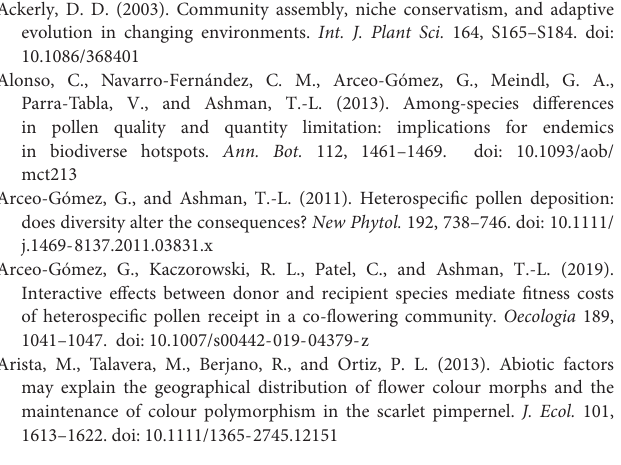
Supplementary Methods 1 | Detail of color vision modeling equations used in